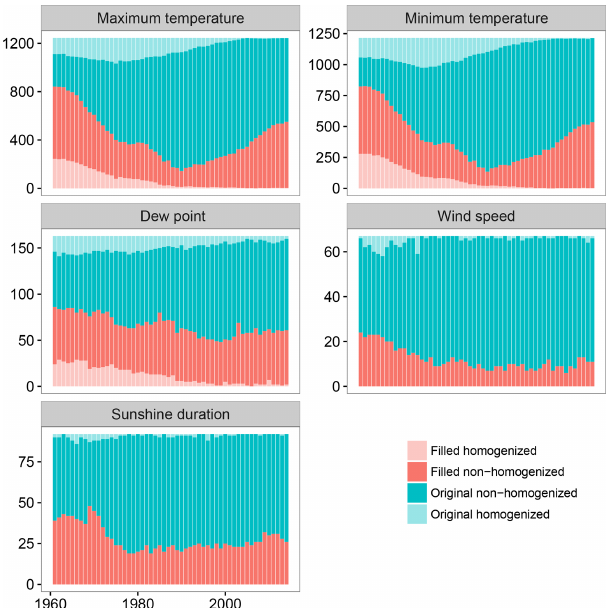
Figure 5. Temporal evolution of the number of filled data for the different climatic variables. The temporal evolution of the homoge- nized data is also shown.